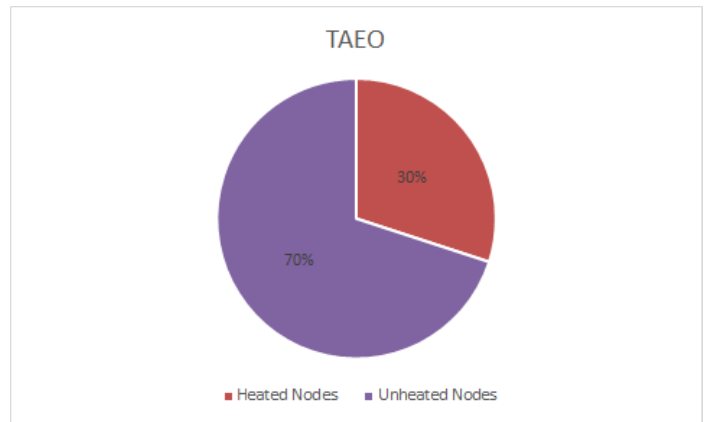
Figure 6. Heated Vs Unheated Nodes.